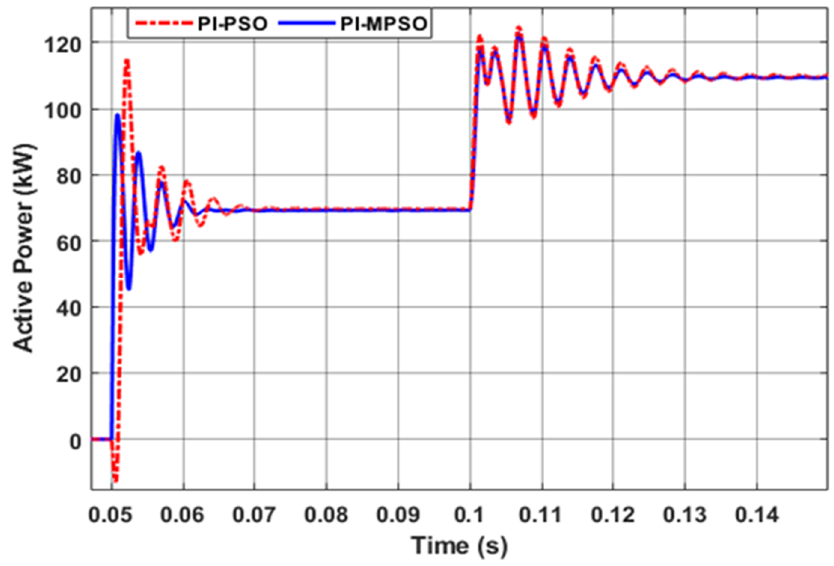
Figure 7. Active power comparison .